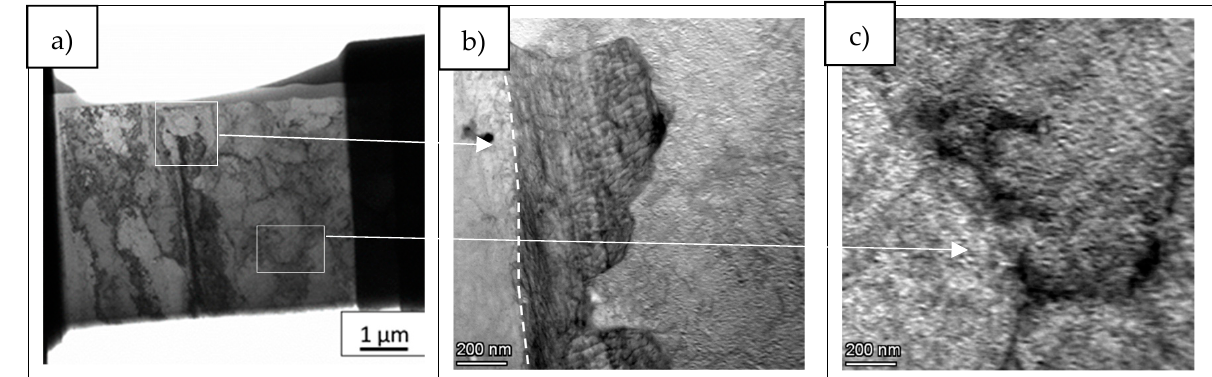
Figure 6. (a) LPW lamella, ( b ) grain boundary and ( c ) cell boundary.